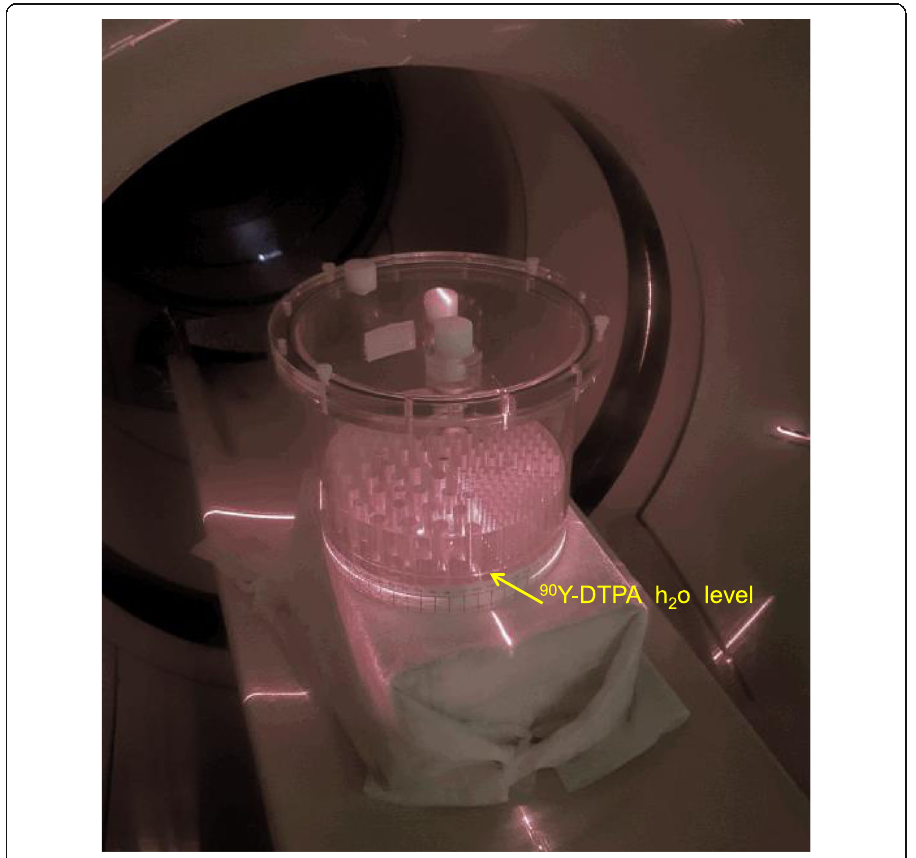
Fig. 1 Jaszczak deluxe phantom set in vertical position on a 20-cm-thick paper bloc modelling the conventional attenuation as only a part of the hot rod insert was filled with active solution in order